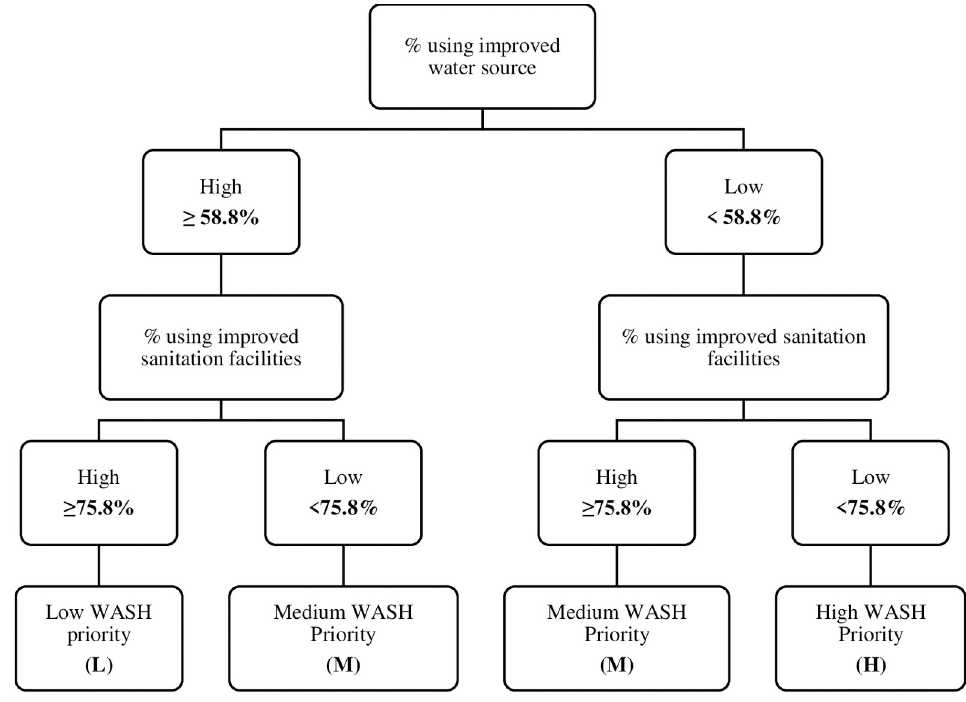
Fig 2. Prioritization by WASH